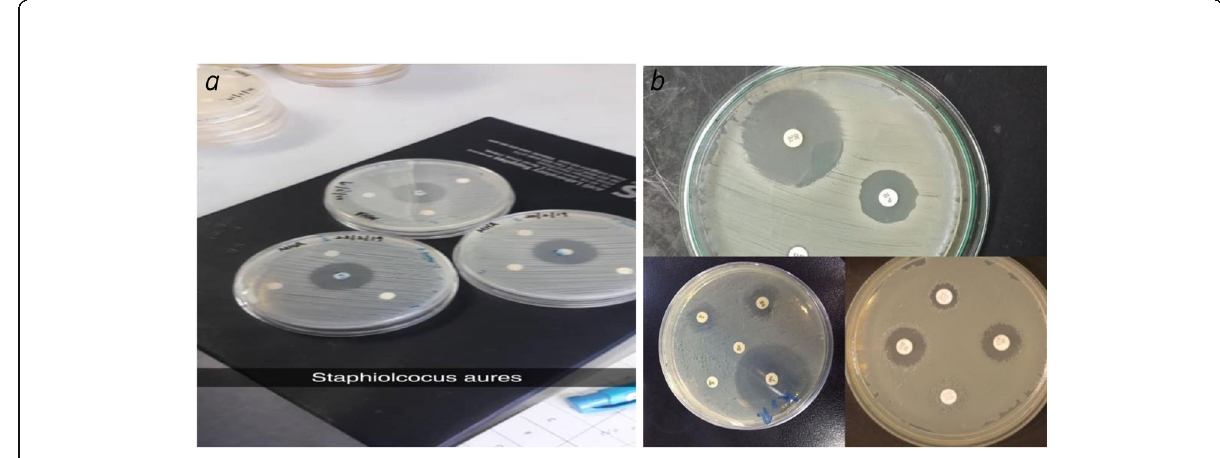
Fig. 5 demonstrate the histograms and inhibition zone (IZ) image respectively of the anti-bacterial growth in media ( a ) against gram-positive Streptococcus pyogens ( S. pyogenes ) replicate three media n = 3. ( b ) in Staphylococcus aureus ( S. aureus ) pathogens, which induced by carbon nanotubes at 400 μ g mL − 1 concentration and composite carbon nanotubes doped with Iron Oxide NPs at three different concentrations ratios (20, 38, 42%) in three